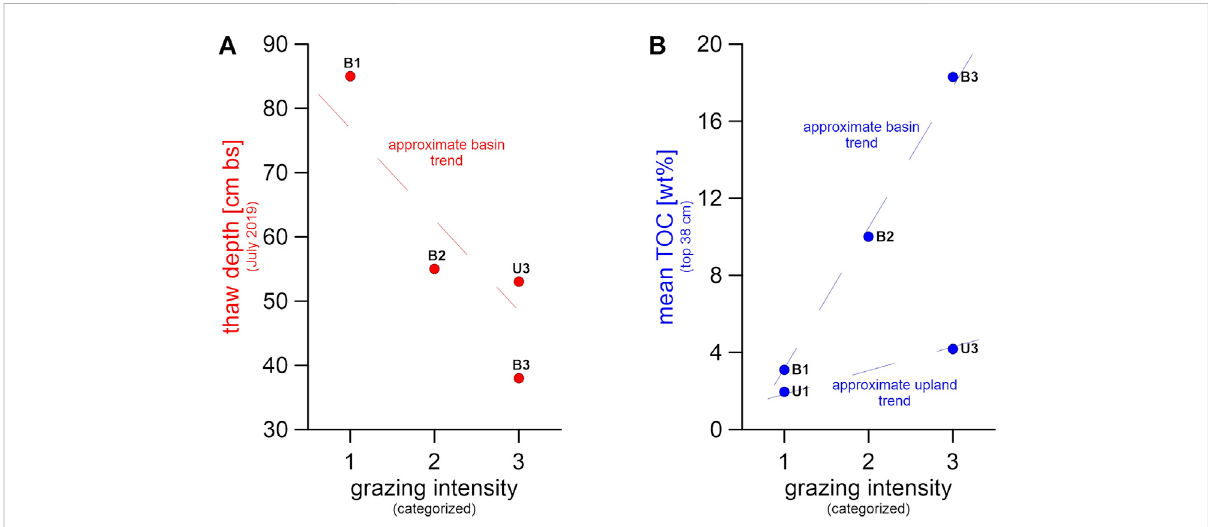
FIGURE 9 Visualization of (A) thaw depth and (B) mean total organic carbon (TOC) of the uppermost 38 cm for all sampling sites, plotted versus grazing intensities 1 (no grazing) to 3 (intensive grazing); as site U1 was only sampled in winter, we do not have a summer thaw depth measurement for this